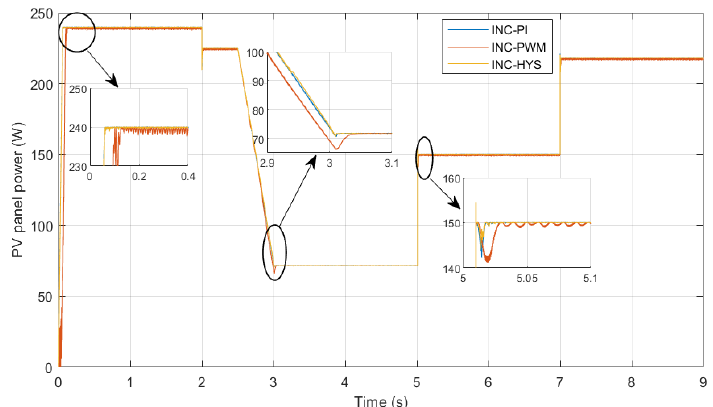
Figure 17. PV panel power comparison using INC-PI, INC-PWM and the proposed technique.